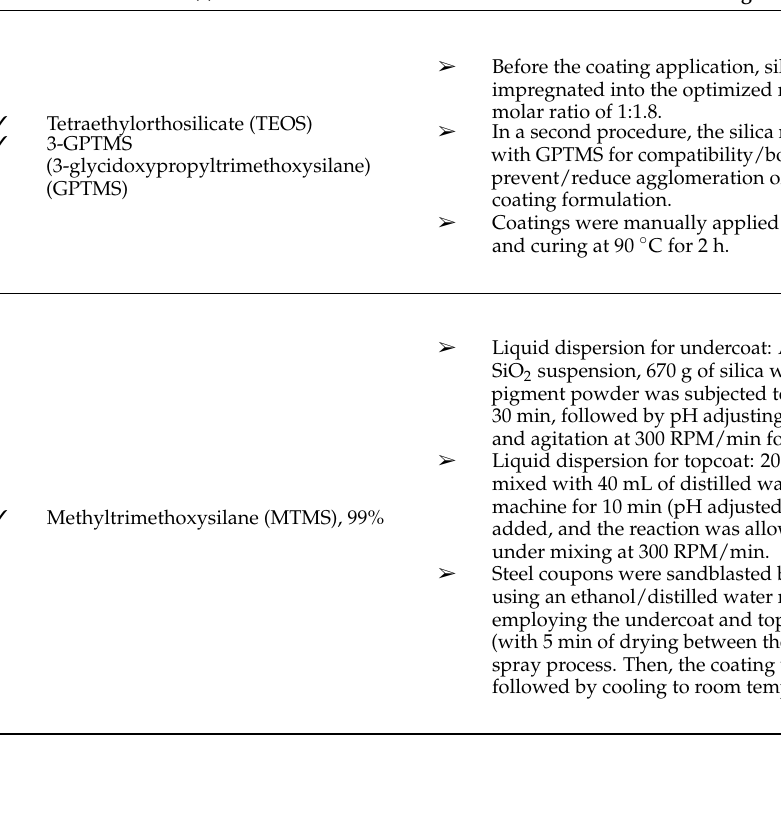
Table 1. Different approaches for improving silane coatings and the main findings, as reported in the literature. Silane(s) Used Coating Preparation Main Findings Ref.